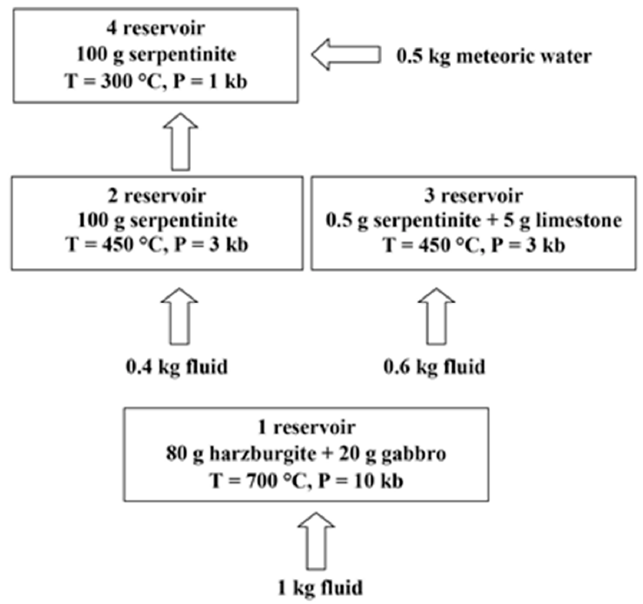
Figure 6. Scheme of the four-reservoir model.